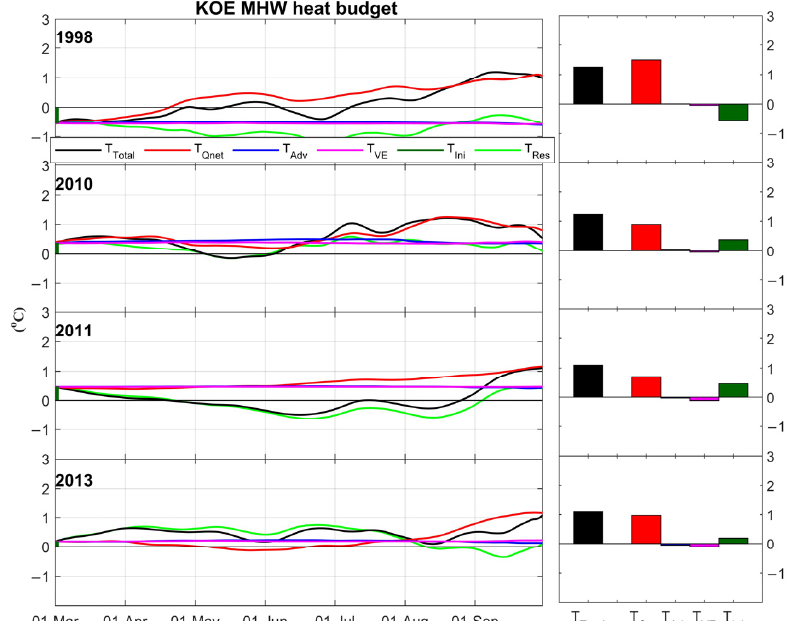
Figure A1. ML temperature anomaly budget of the MHW years. Contributions from different terms to the temperature change from March to the summer peak values are shown in the right panels. Initial value contributions are denoted with dark green bars. The units of the right panels are the same as the left panels.